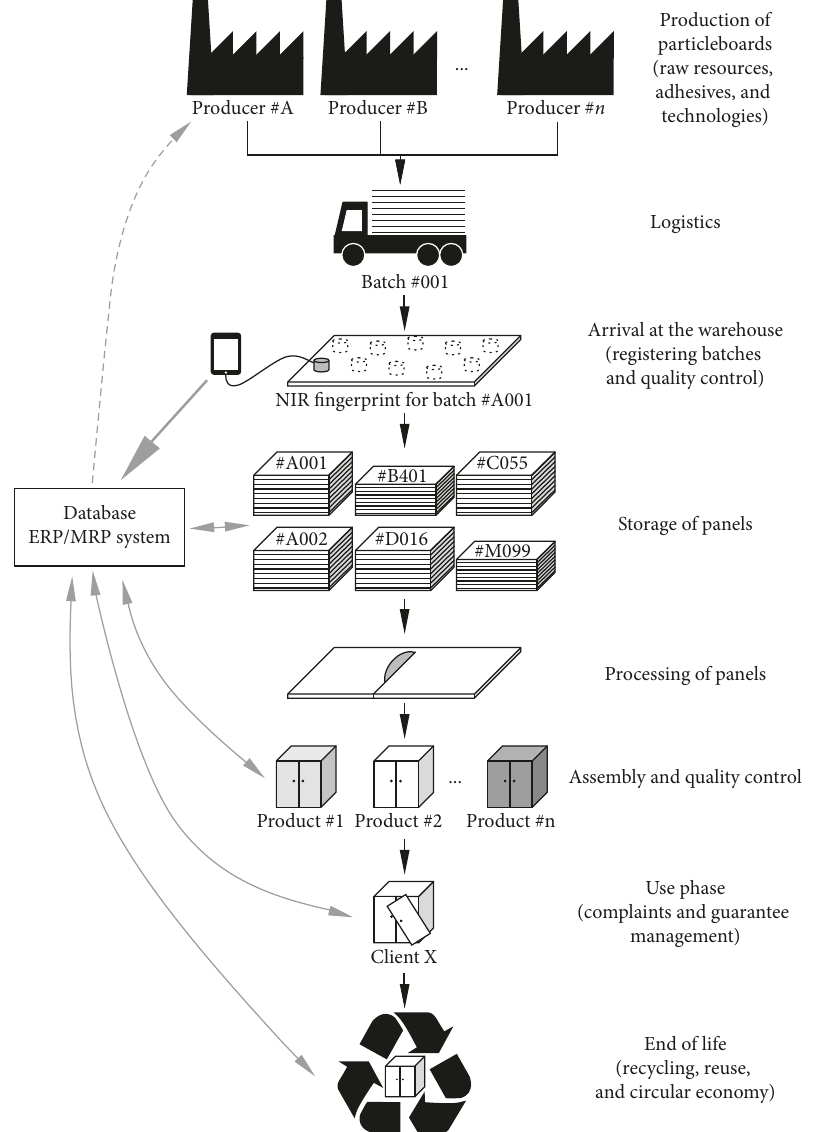
Figure 2: Concept for the traceability of particleboards in the furniture